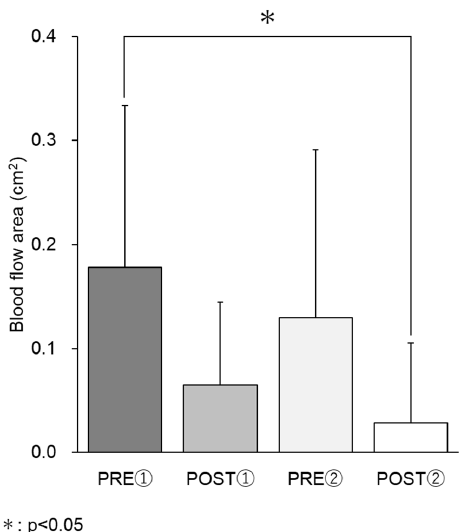
Figure 6. Patella tendon thickness.